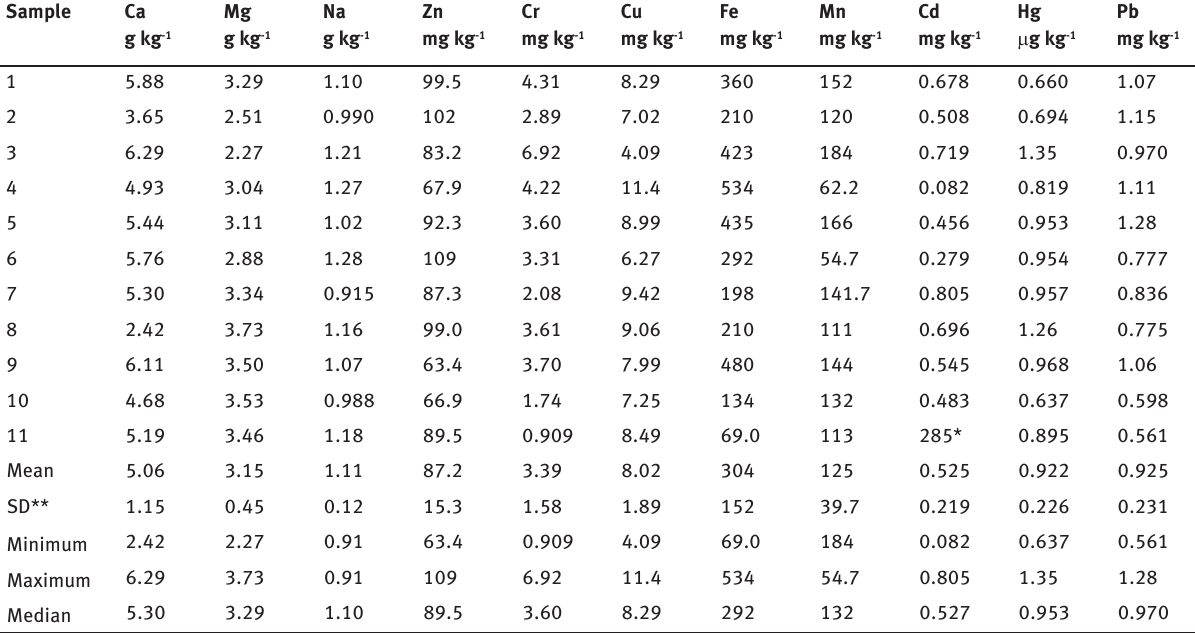
Table 4: Elemental content in analyzed tea chamomile samples expressed as a dry mass of the sample (mean of three measurements) Sample Ca